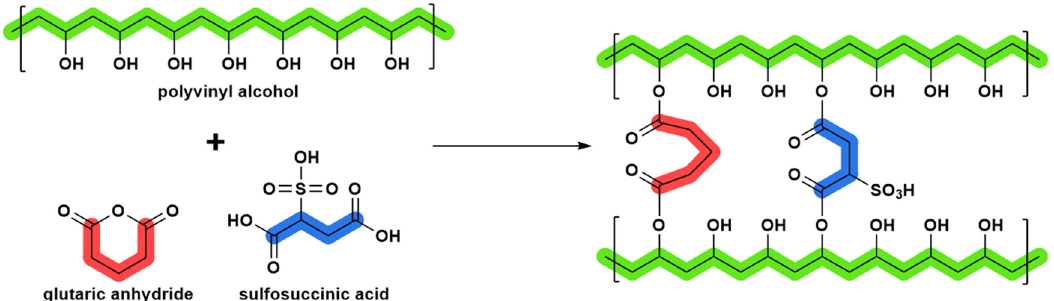
Scheme 1: Expected cross - linking reaction between SSA with